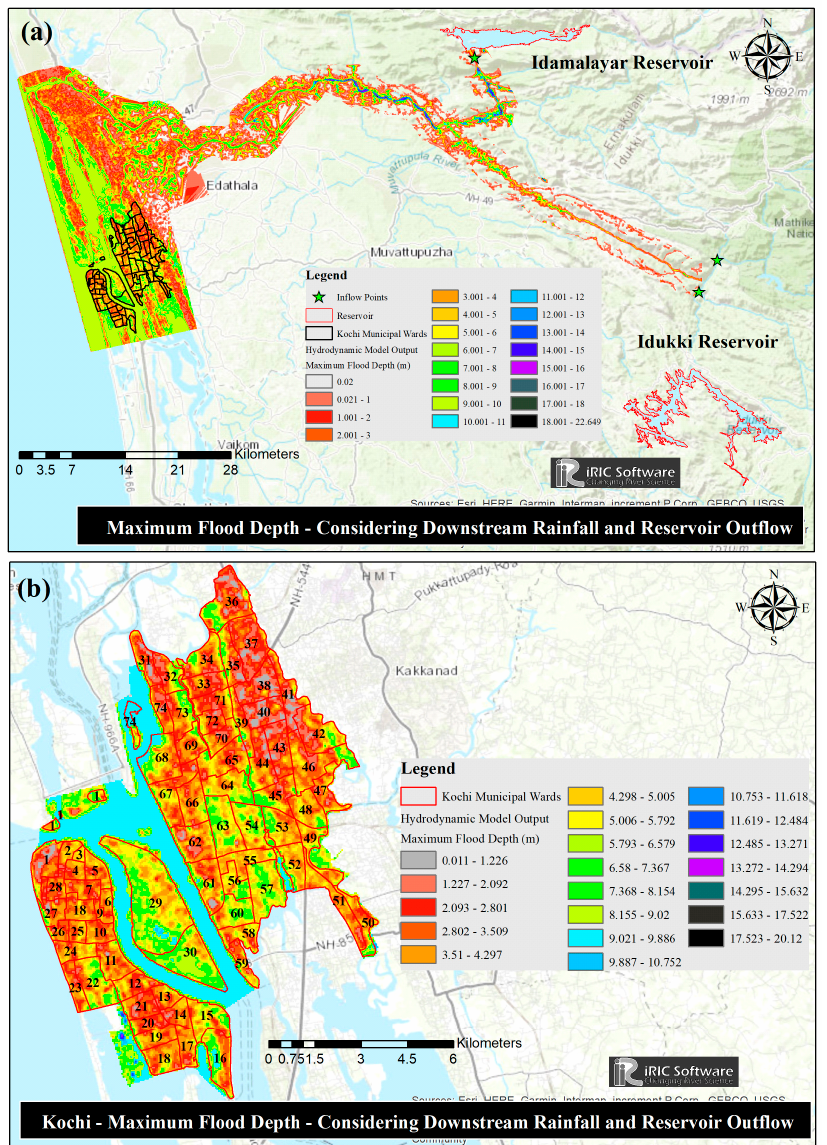
Figure 13. Hydrodynamic model flood depth output of Kochi city and Periyar river basin under Controlled Flow Condition (with reservoir) considering downstream rainfall where ( a ) shows complete inundation of the downstream portion of the basin and ( b ) shows complete inundation in the Kochi city